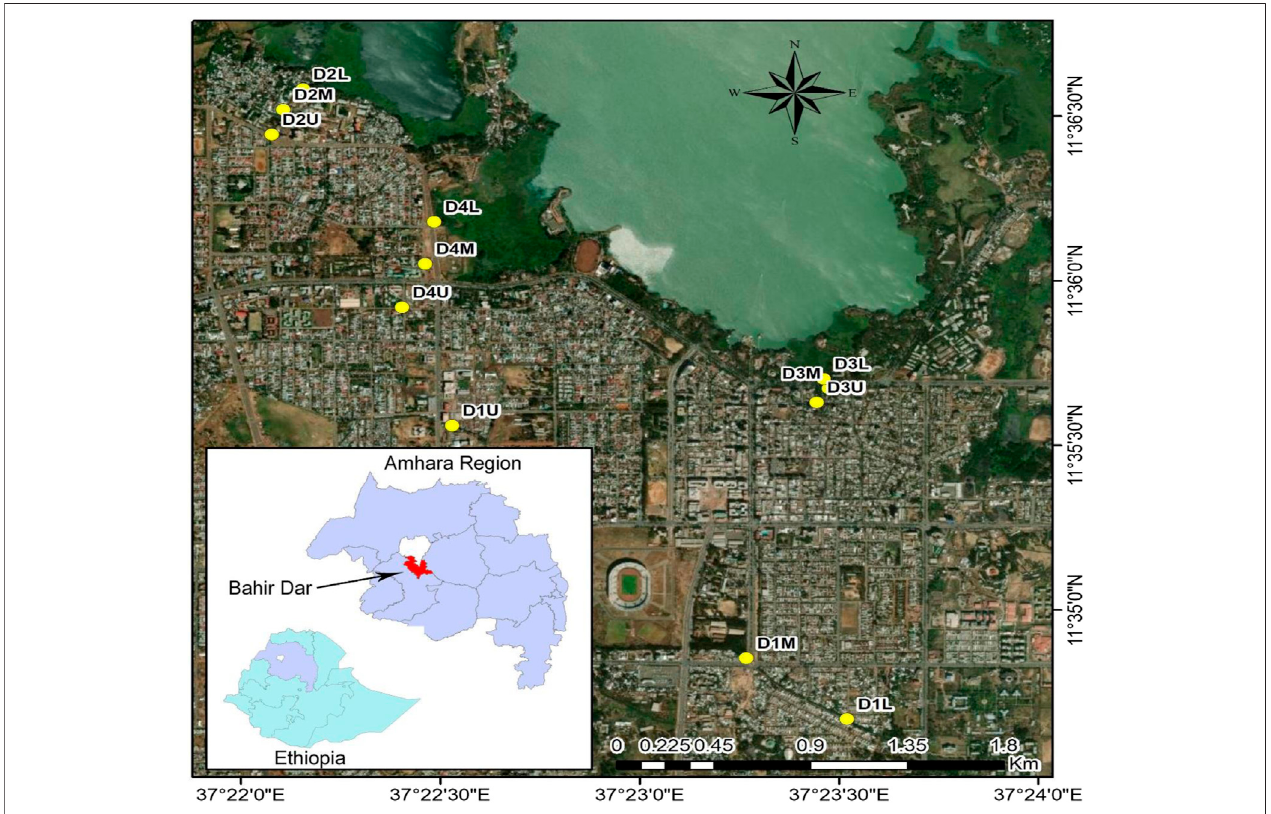
FIGURE 1 | Map of the study area with the three locations at each of the four major ditches in the city. Yellow dots indicate sampling locations.